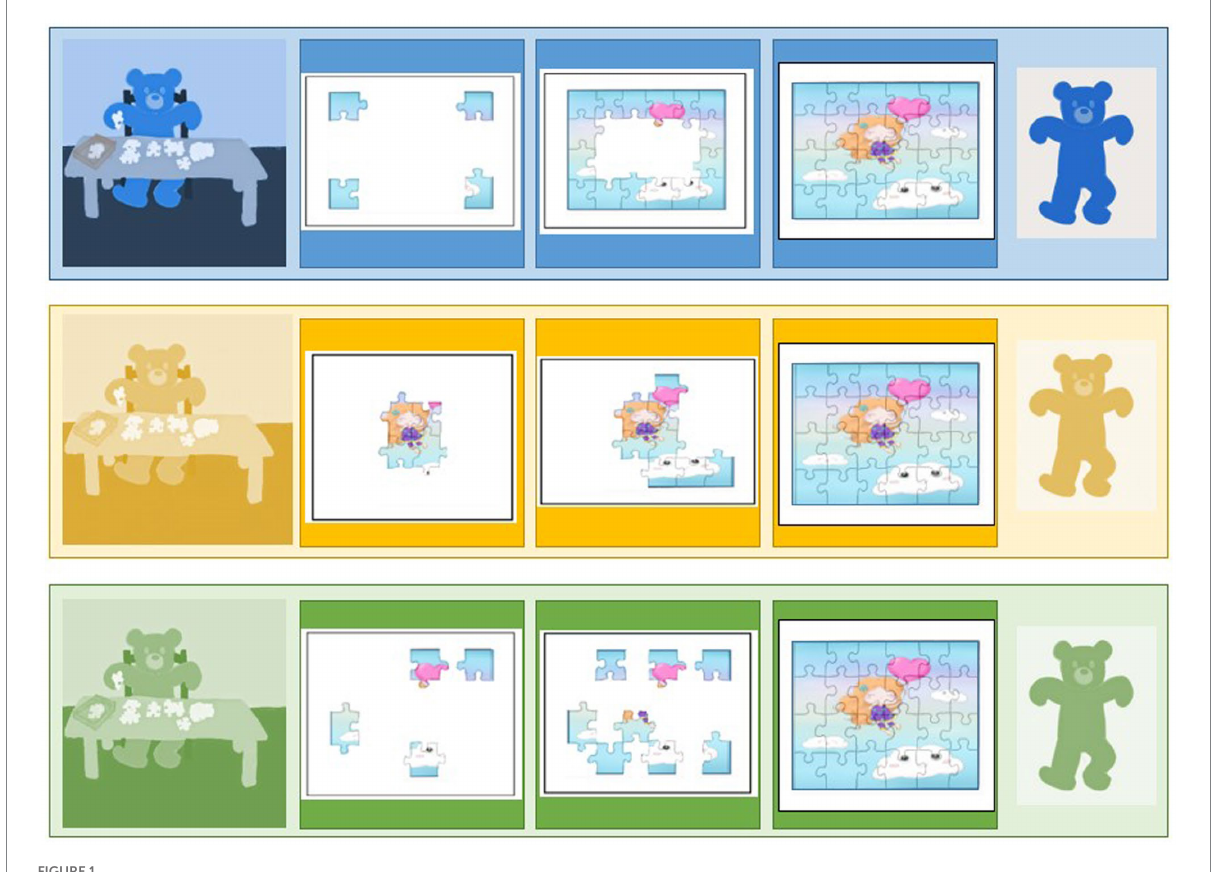
FIGURE 1 Representation of the Goal Choice Teddy Boards. The real size corresponds to 6 x 29,7 cm, for each one. The original version used in the study was made with pictures of the steps of making a jigsaw puzzle with the Ravensburger Puzzle 4+ N° 08 993 2 with the character Nihao Kai-Lan from Nickelodeon. For a question of authorization of the image rights, an adapted version was carried out for the present article with a free image carried out by Tarisha of Pixabay being close to the initial